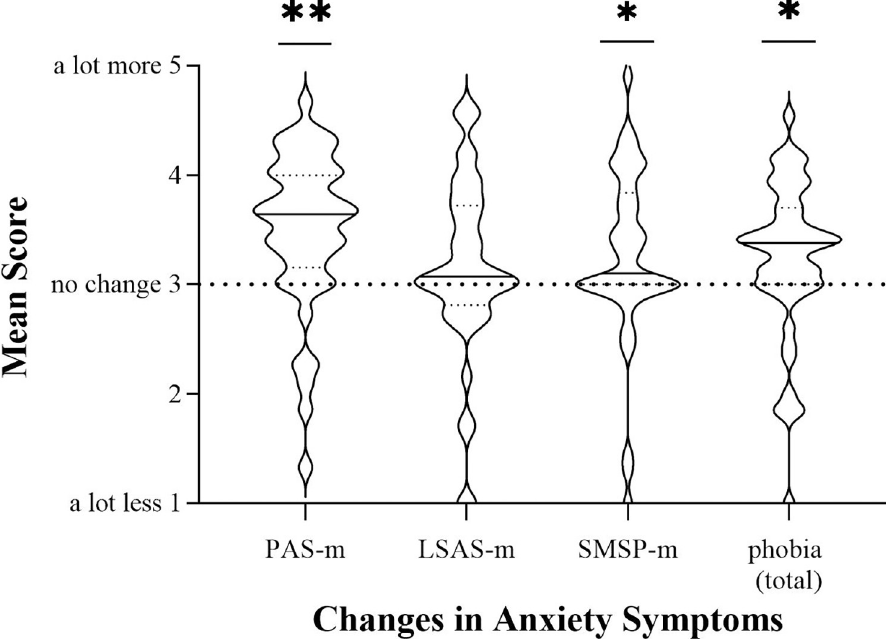
Fig 1. Changes in anxiety symptoms during and after the first wave of the pandemic. Mean scores of changes in symptoms of panic disorder, social anxiety disorder and specific phobia. Significance levels indicate difference from a mean score of three, which would be no change. The solid line within the violin plots illustrates the median, and the dashed lines show the interquartile range. ��� p < .001. �� p < .01. � p < .05.